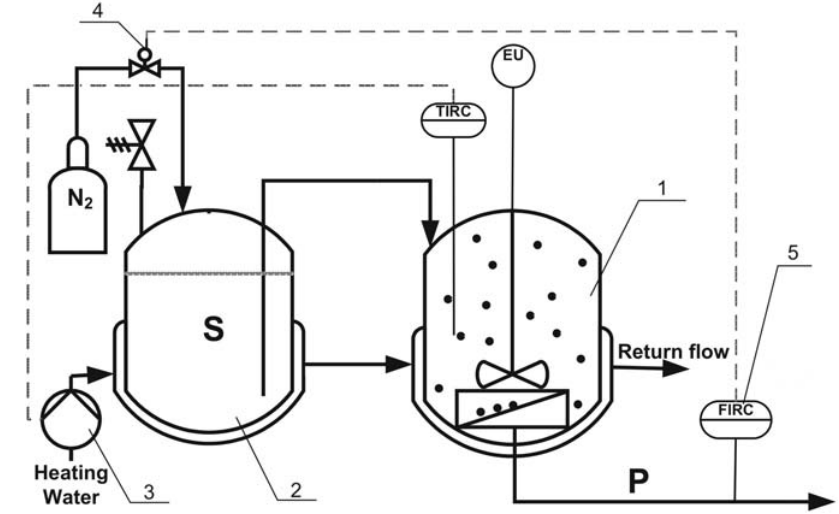
Figure 1. Developed screening system based on the membrane continuous stirred tank reactor (MCSTR) concept: (1) membrane reactor; (2) substrate tank; (3) thermostat; (4) pressure regulator; (5) precision balance; ● enzymes; S: substrate; P: product